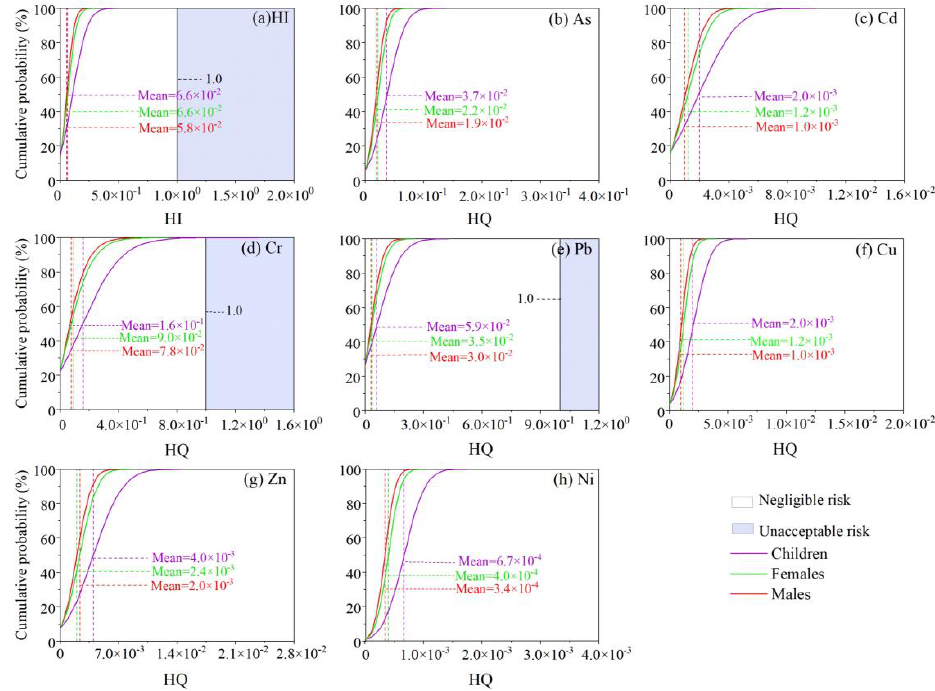
Figure 6. Hazard quotient (HQ) of the cumulative probability of noncarcinogenic risk of each trace metal and hazard index (HI) values for the cumulative probability of total noncarcinogenic risk in road dust from Guangzhou.